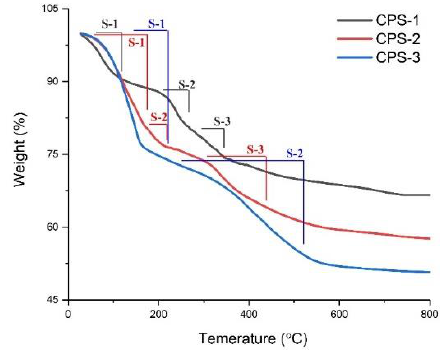
Figure 7. Thermos-gravimetric analysis (TGA) analysis of CPS-1, CPS-2 and CPS-3.